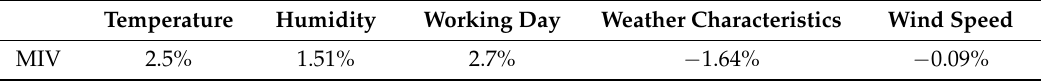
Table 1. Mean Impact Value (MIV) rates (%) for the input factors.